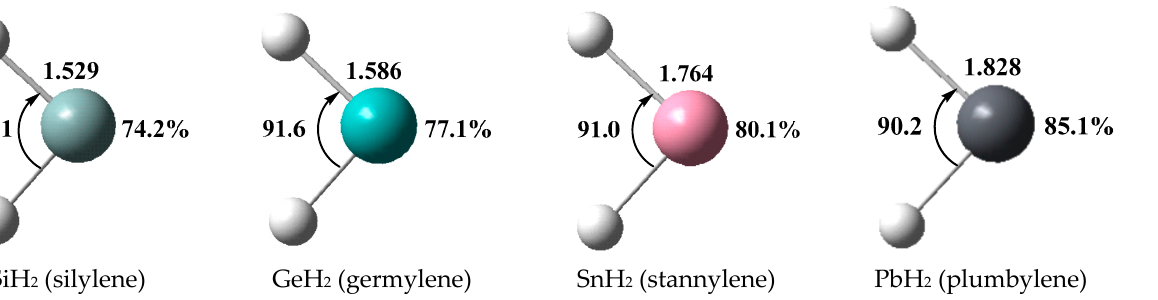
Figure 2. Optimized geometries of the metallylenes TH 2 at the MP2/aug-cc-pVDZ level, distances in Å, angles in °, and the percentage of s-character of the lone pairs.